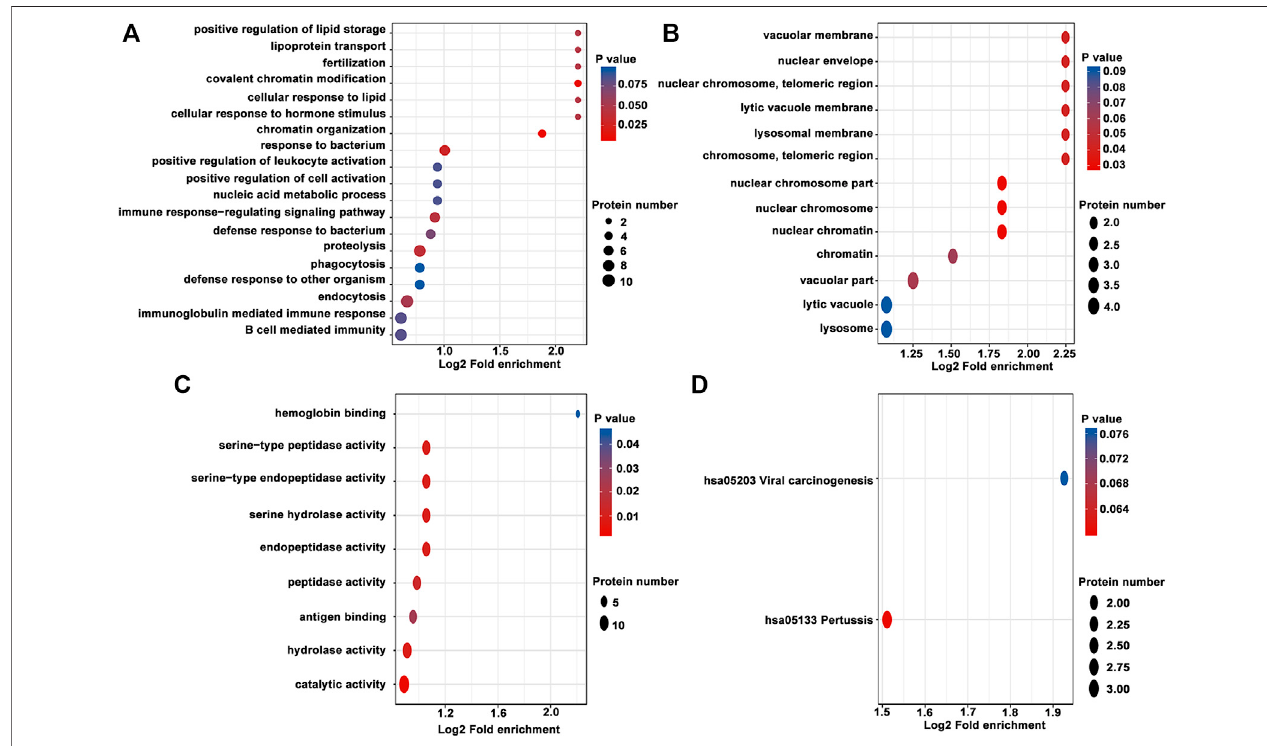
FIGURE 3 | GO enrichment bubble plot of proteins corresponding to differentially expressed modi fi cation sites in three categories. (A) Biological process. (B) Cellular component. (C) Molecular function. (D) KEGG pathway enrichment bubble plot of proteins corresponding to differentially expressed modi fi cation sites.